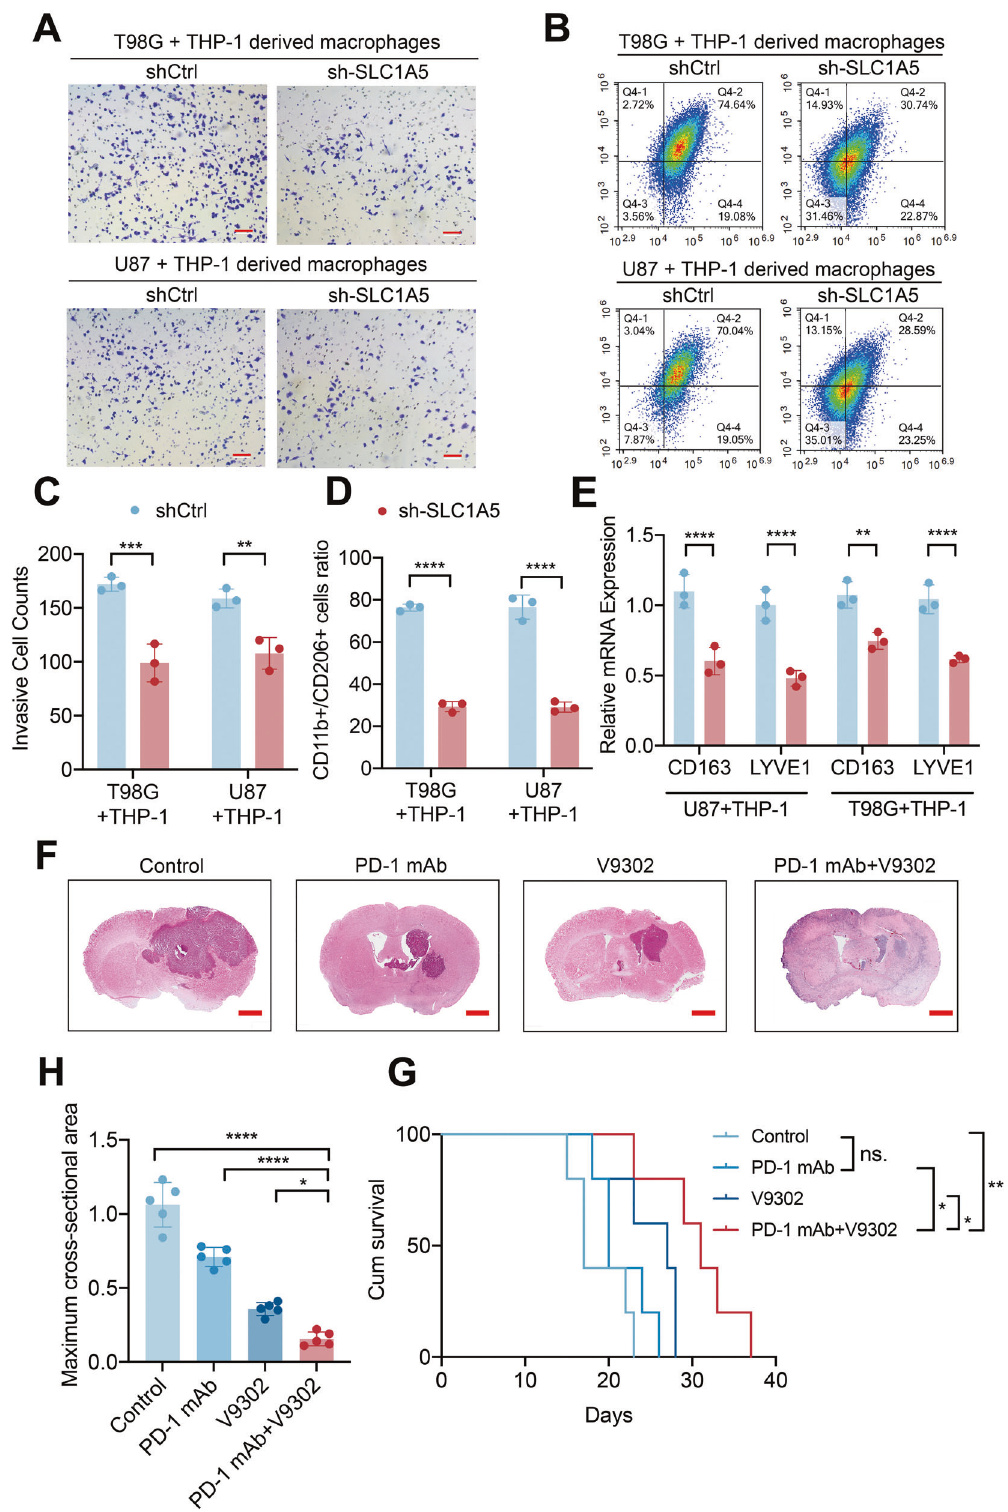
Fig. 8 SLC1A5 modulated THP-1 derived macrophages in fi ltration and its inhibitor synergized with immune checkpoint inhibitor to suppress tumor growth. A , C The migration of THP-1 derived macrophages co-cultured with different groups of GBM cells (Scale Bar = 20 μ m). B , D Flow cytometry results representing the percent of CD11b + CD206 + macrophages after co-cultured with different groups of GBM cells. E Relative mRNA expression of CD163 and LYVE1 (M2 macrophage markers) in THP-1 derived macrophages co-cultured with different groups of GBM cells. F – H The HE staining and tumor size analysis of mice in PD-1mAb and V9302 separate or combined treatment group (Scale Bar = 1 mm). G The survival time of GL261-bearing C57BL/6 mice under different treatments.